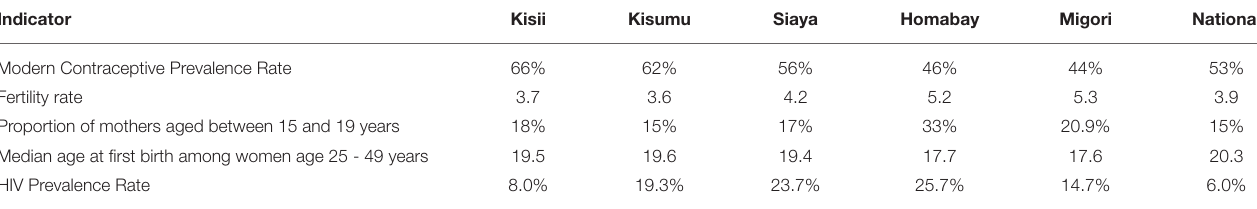
Source: Kenya Demographic and Health Survey 2014